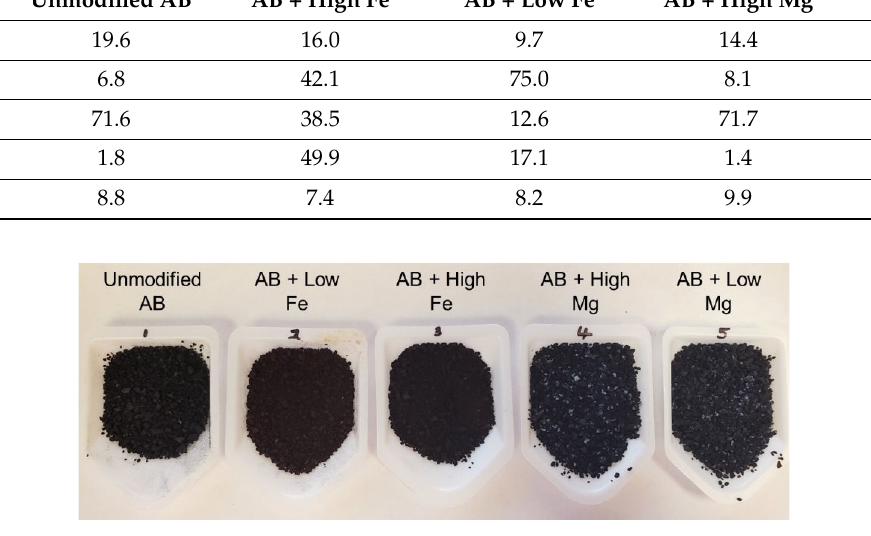
Figure 2. Avocado seed biochar (AB) samples after metal impregnation.